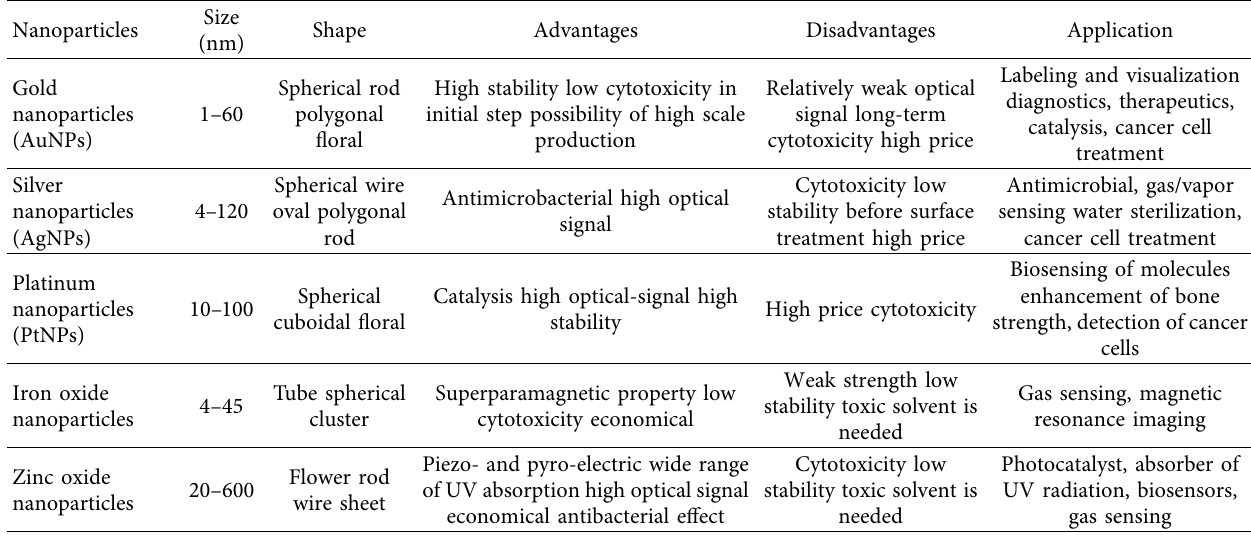
Table 3: Properties of metal nanoparticles